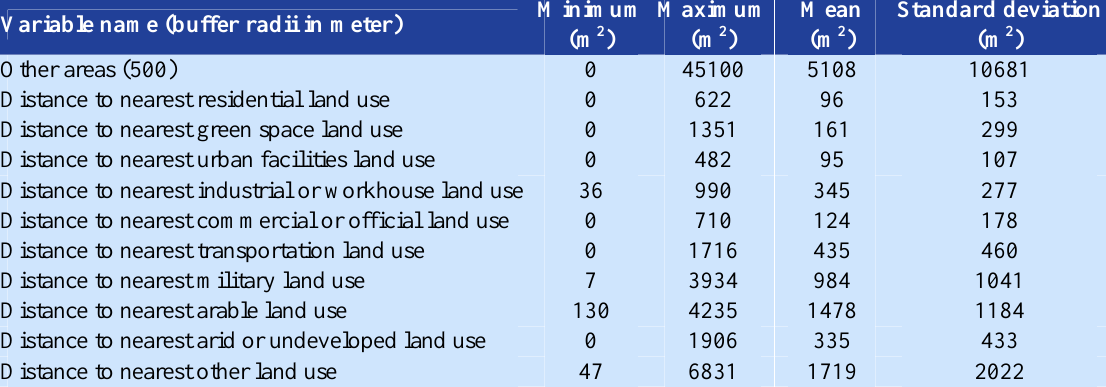
Table 3. Summary of all the land use variables (Continues) Variable name (buffer radii in